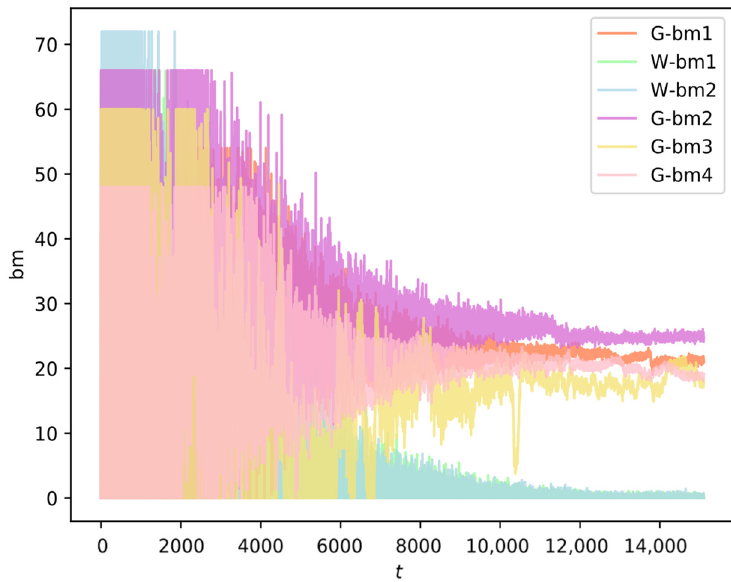
Figure 10. DDPG training convergence results.